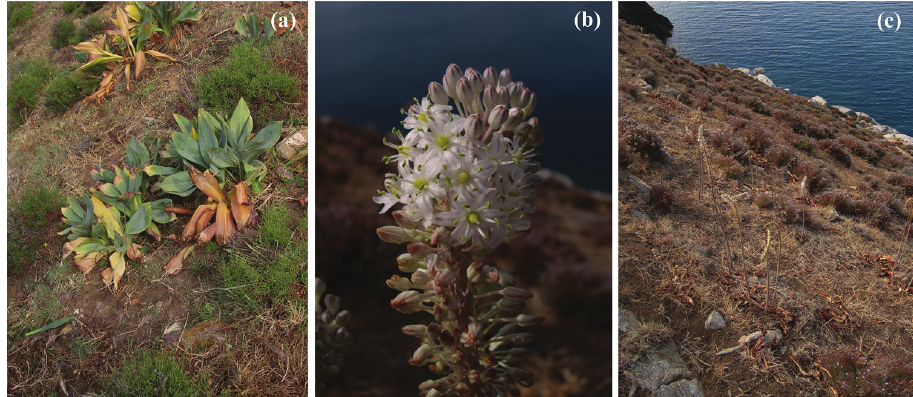
Figure 1. Phenological features of Charybdis glaucophylla Bacch., Brullo, D’Emerico, Pontec. & Salmeri; of winter foliation ( a ), summer flowering ( b ) and natural late-summer habit ( c ) in Sardinia. Photograph by G. Bacchetta.